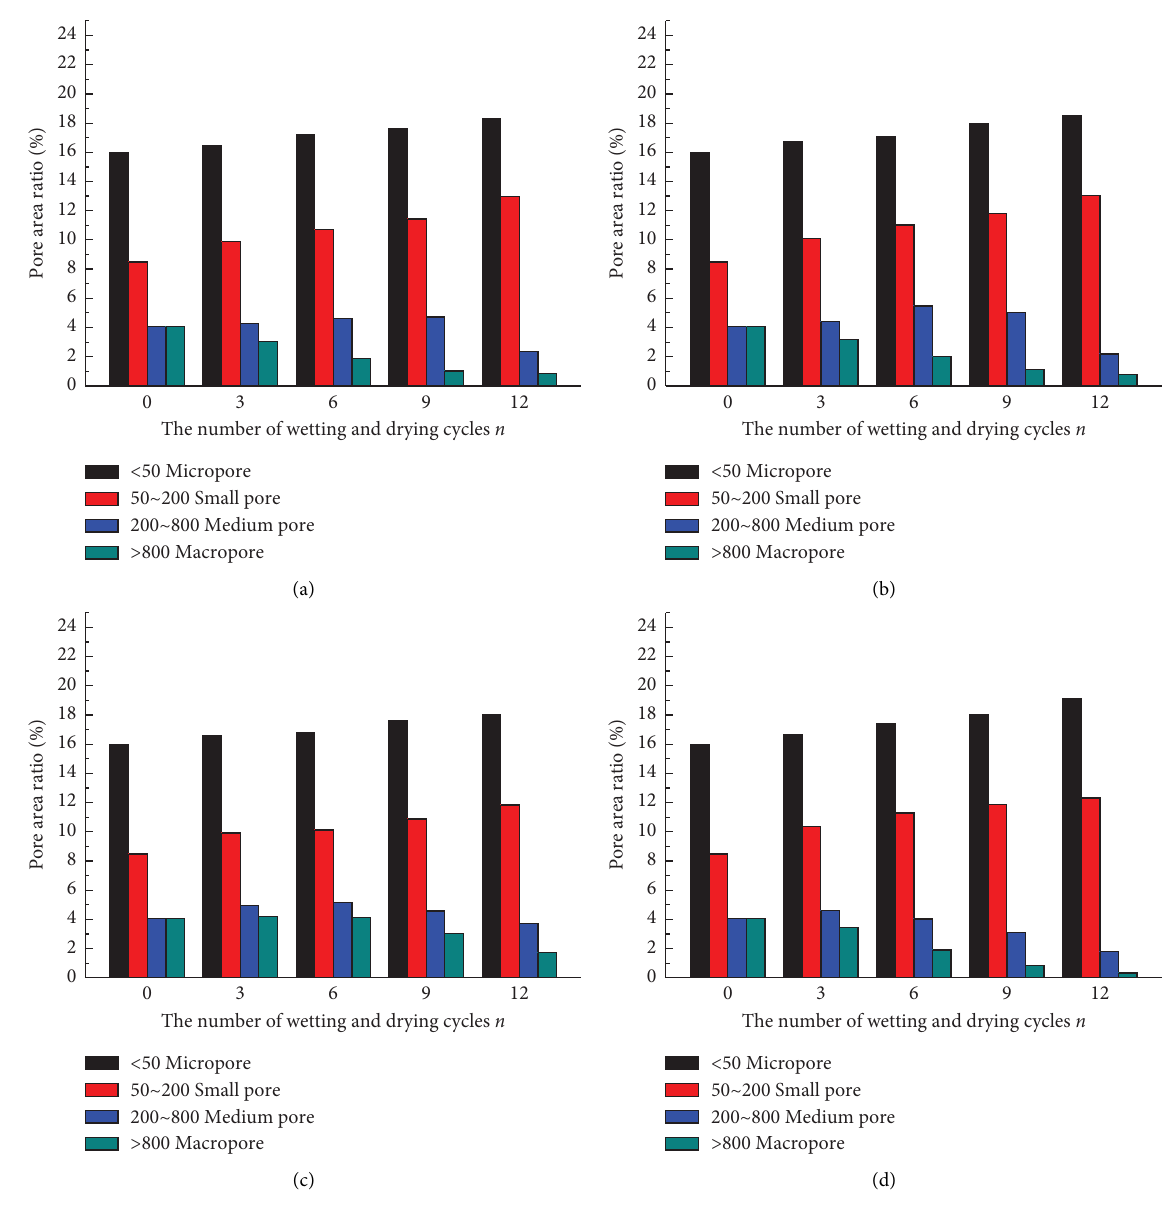
Figure 14: Changes of area ratio of diferent pore types. (a) W - D cycle path a. (b) W - D cycle path b . (c) W - D cycle path c . (d) W - D cycle path d